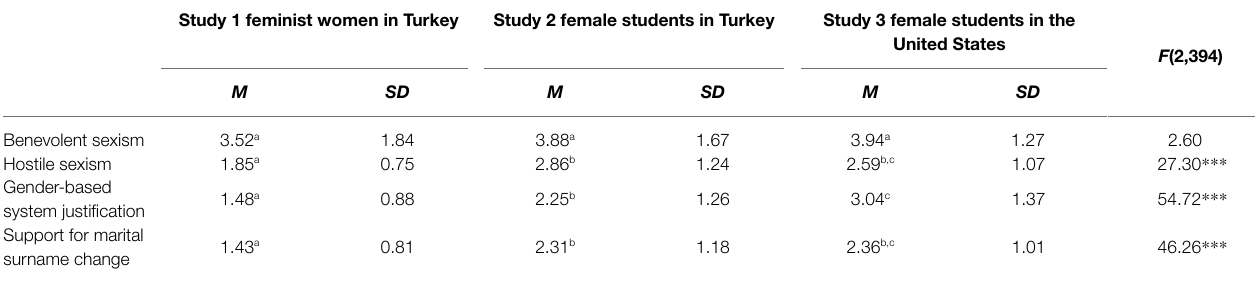
TABLE 3 | Means and SDs among the samples in Studies 1–3.